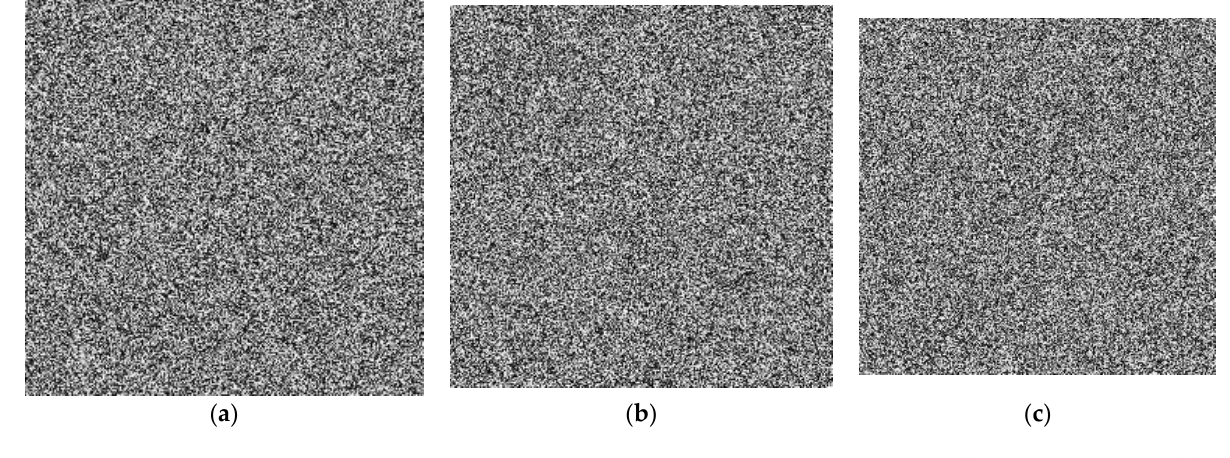
Figure 7. Decrypted image using incorrect keys ( a ) x 0 = 0.16 + 10 − 14 ; ( b ) k 1 = 32.5 + 10 − 14 ; ( c ) µ = 3.999 + 10 − 14 .